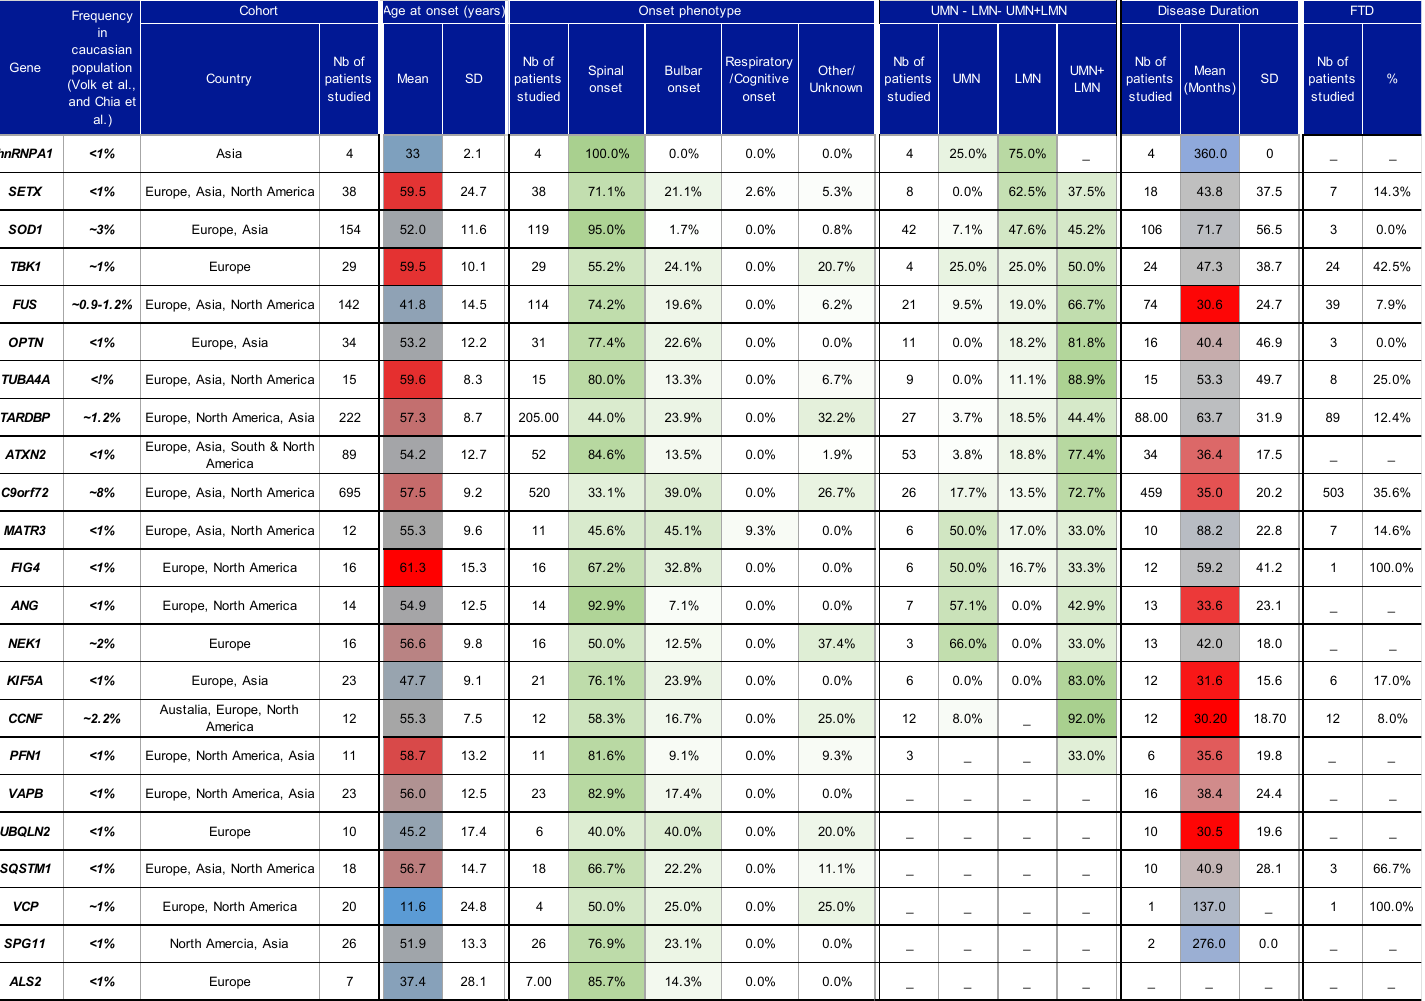
Figure 4. Table summarising the phenotypes observed in ALS patients with different mutations. A detailed version of this table is accessible as supplemental data (Table S2). PubMed was searched to identify published studies reporting genotype–phenotype data for 23 genes. Column 2 indicates the frequency of genes observed